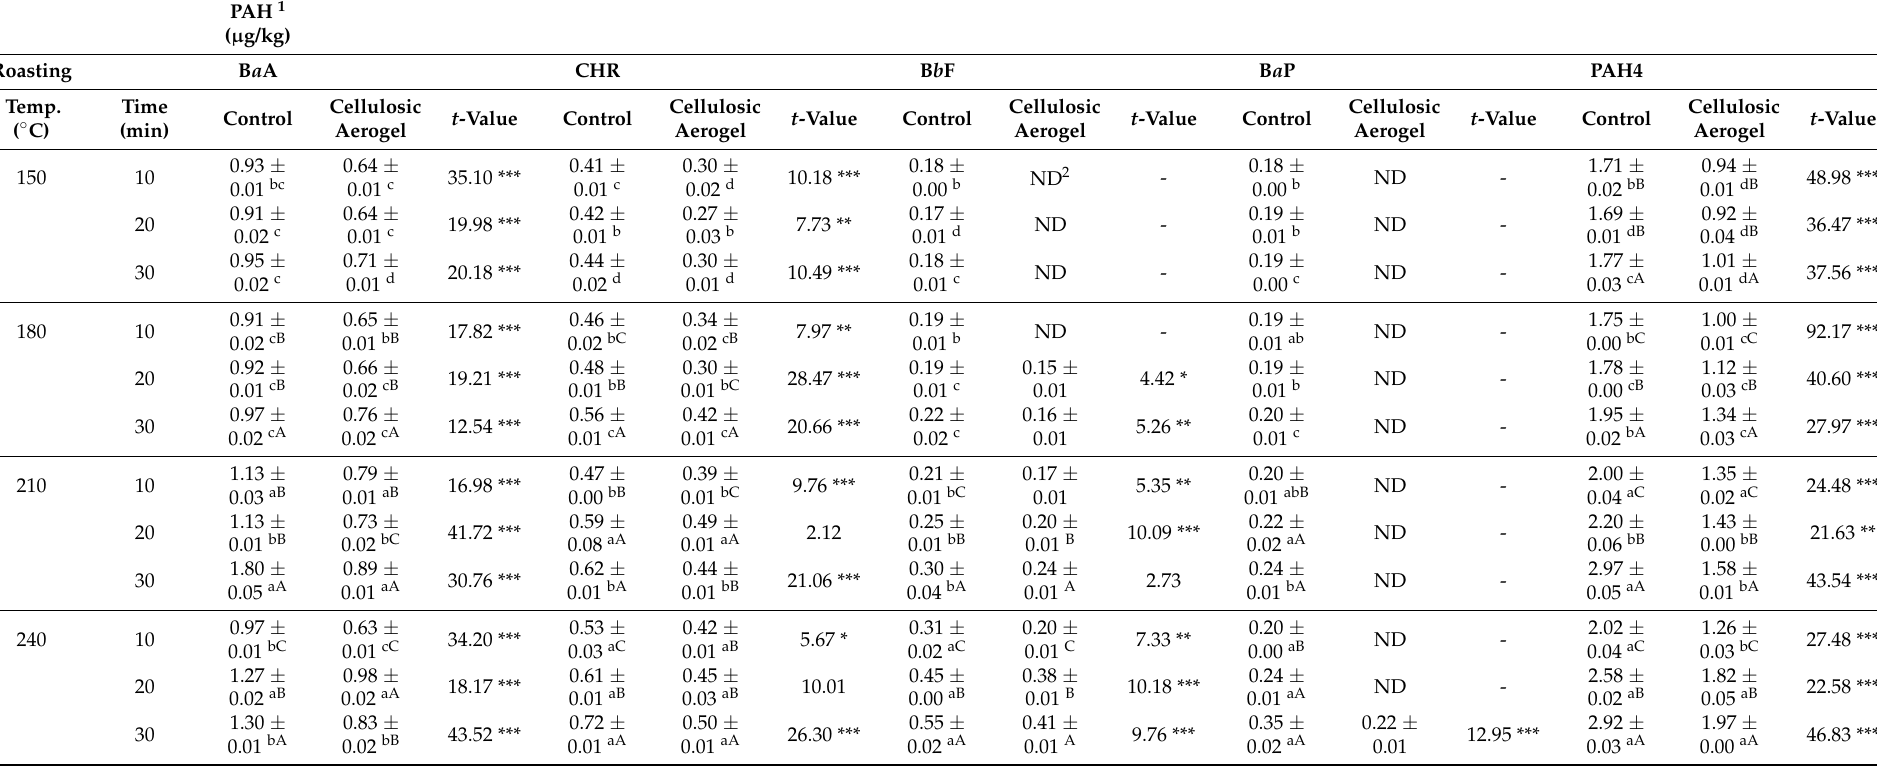
Table 2. Polycyclic aromatic hydrocarbon (PAH) levels ( µ g/kg) in sesame oil without and with cellulosic aerogel